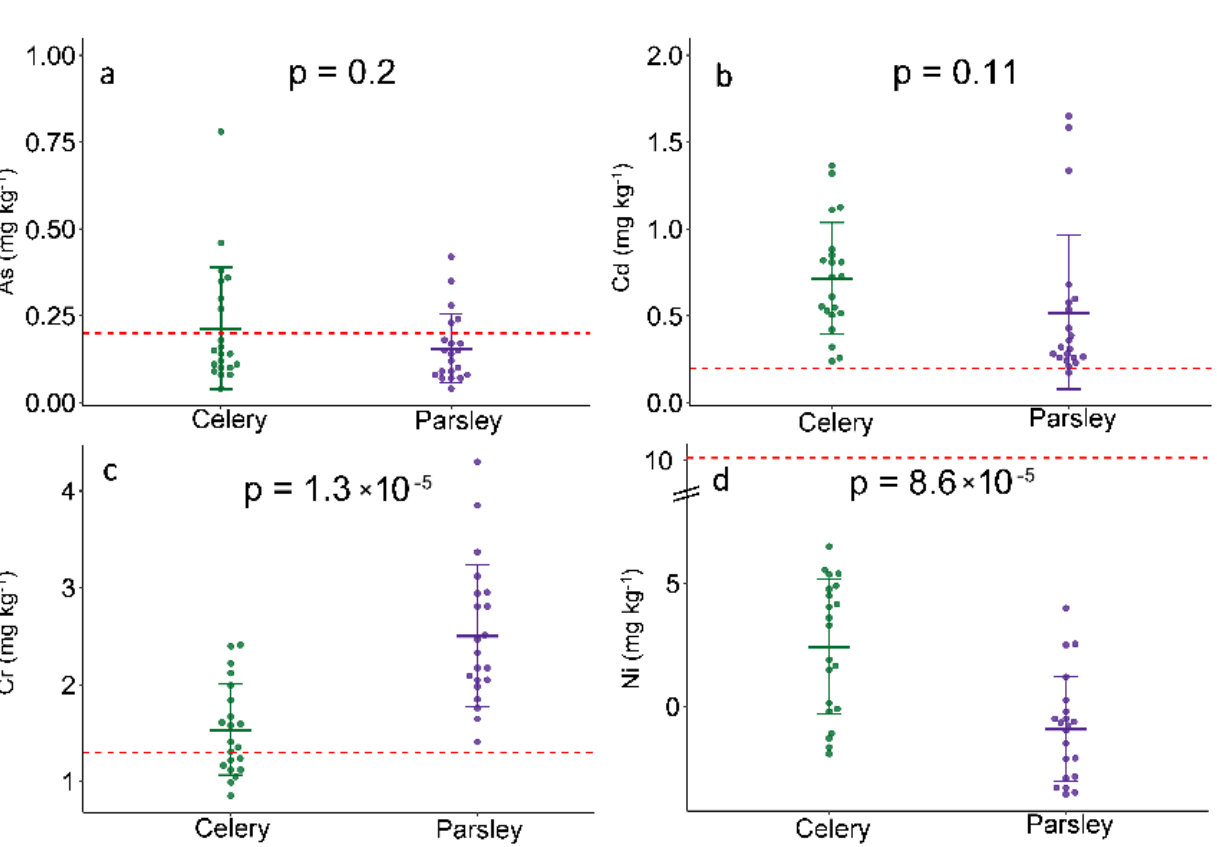
Table 1. Estimated daily intake—EDI (mg/kg/bw) of Ni, Cd, Cr, and As in celery and parsley. Values are presented as the mean ( n = 21) ± standard deviation (SD) and compared with the tolerable daily intake (MTDI) mg/kg.